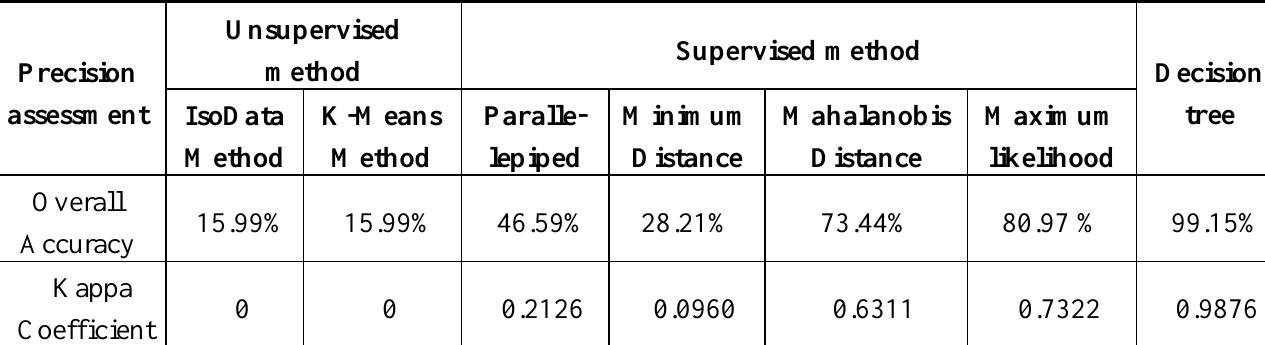
Table 4. Forecast precisions of decision tree and the other six ones.